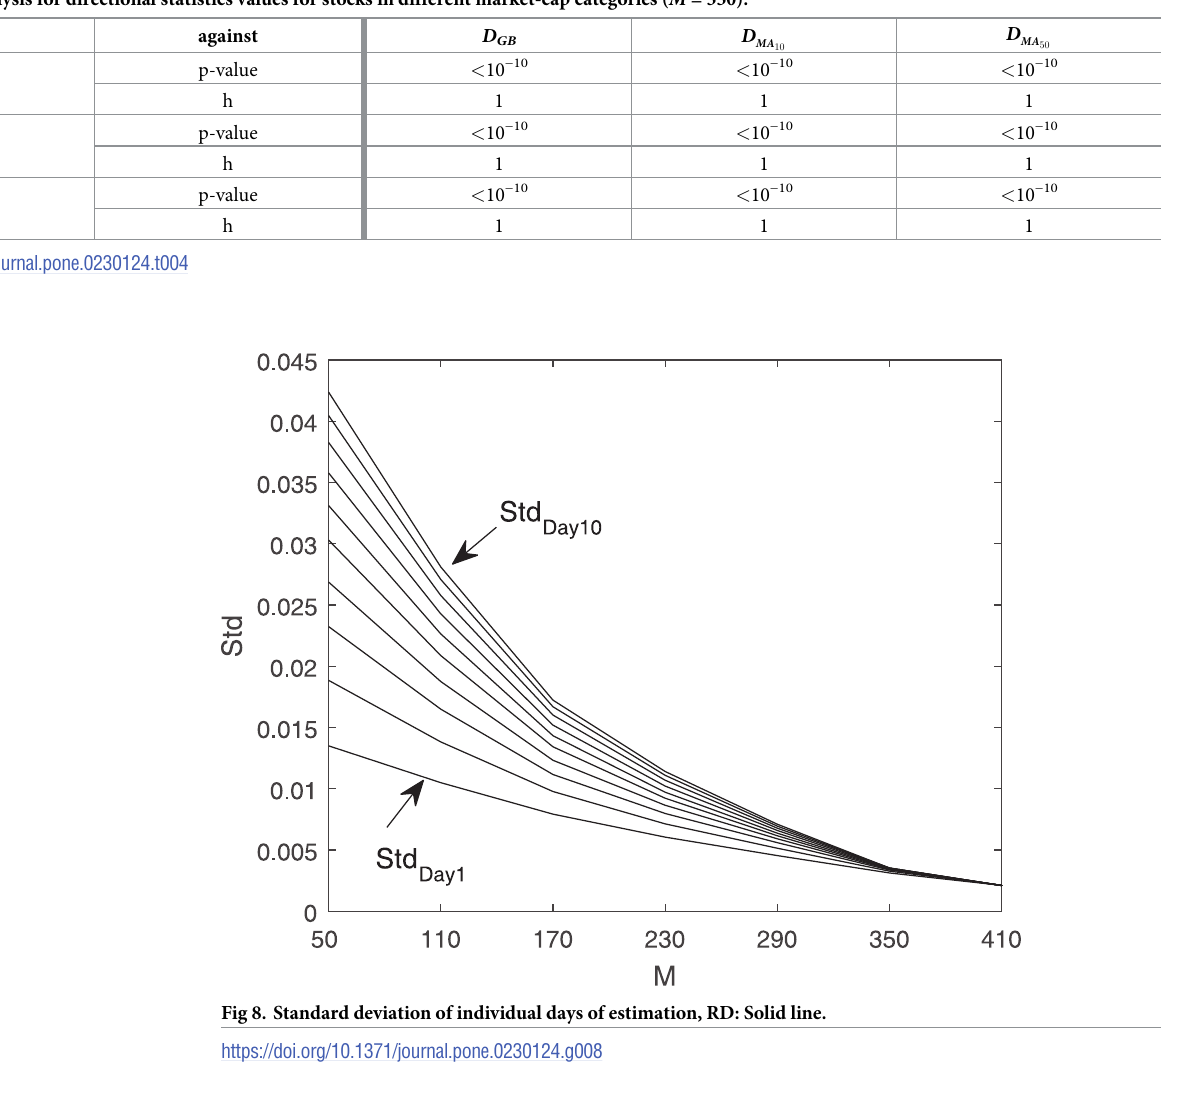
Table 4. Statistical analysis for directional statistics values for stocks in different market-cap categories ( M = 350).